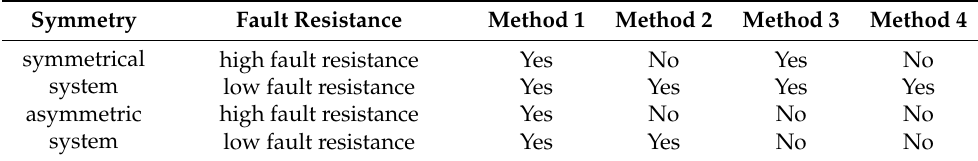
Table 5. The faulty phase selection results of Method 1, Method 2, Method 3 and Method 4.